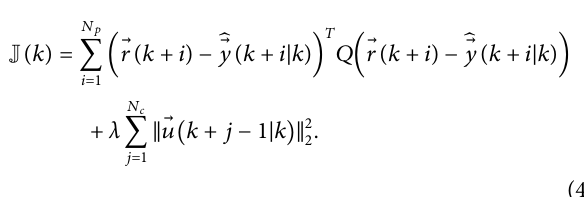
Frontiers in Physiology |